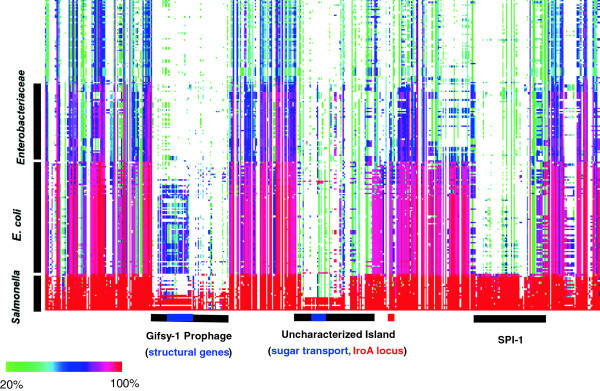
Use of CodaChrome to identify genomic islands in closely related organisms. The figure shows an expansion of a section of the CodaChrome heat map shown in Figure 1.